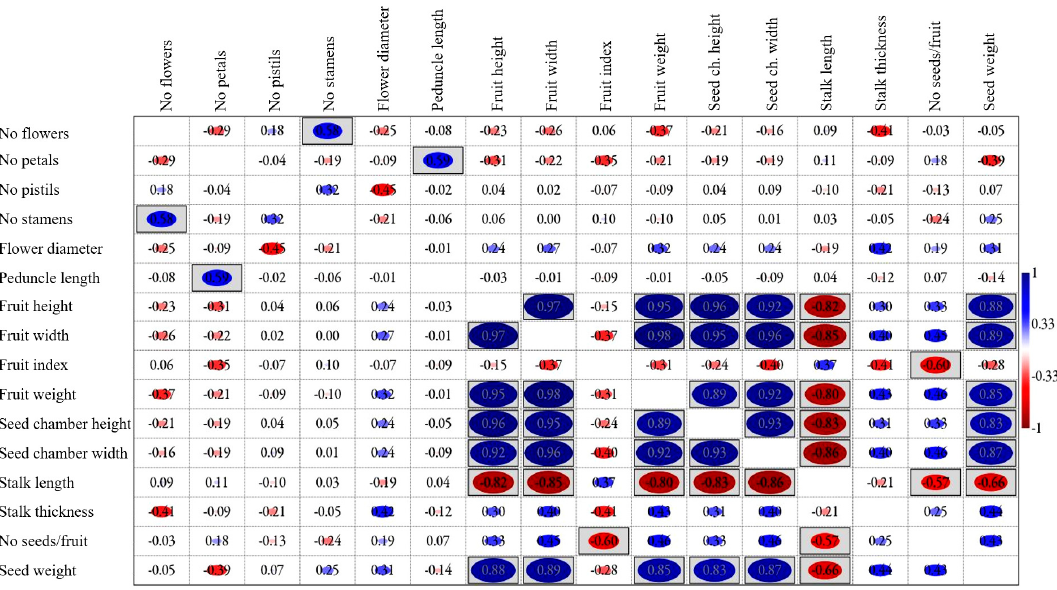
Figure 6. Phenotypic correlations between physico-morphological characteristics in 15 cultivars of ornamental crabapples analyzed (linear Pearson correlation; significant positive or negative correlations are enclosed in a grey box, p <